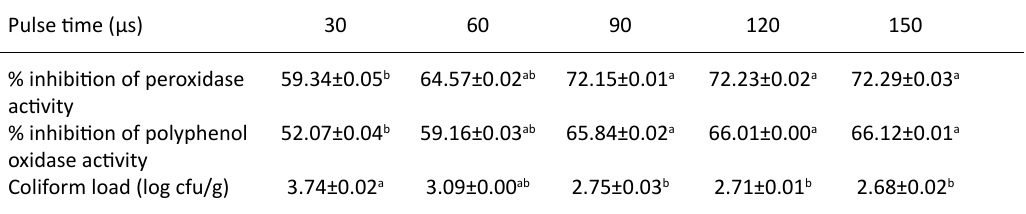
table 2. Impact of pulse time (µs) of PEF ahead-treatment to enzymatic and microbial inactivation in flower Pulse time